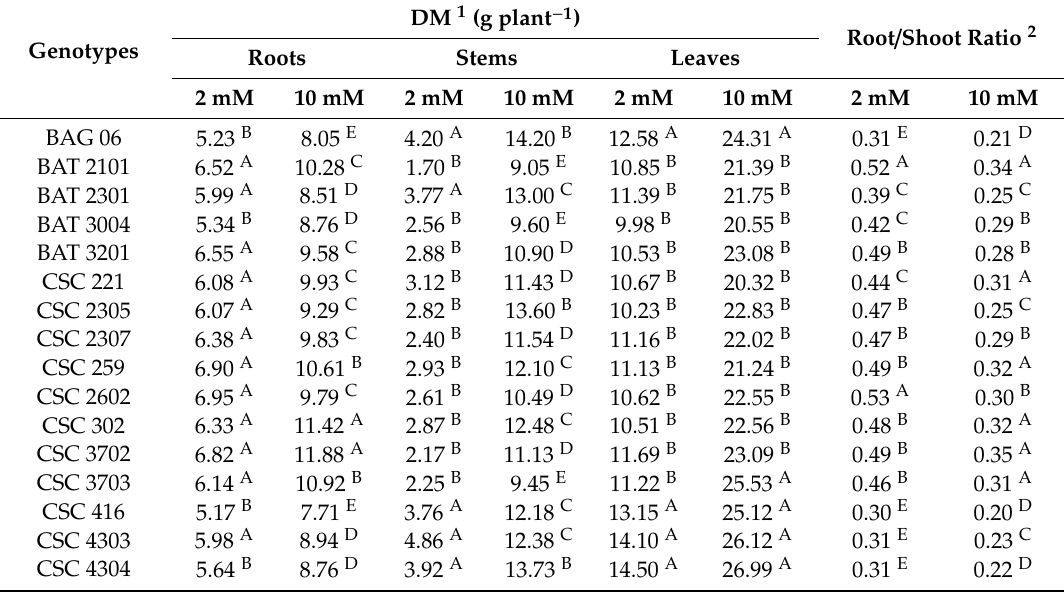
Table 1. Means of dry mass (DM; g plant − 1 ) of the roots, stems, and leaves and the root / shoot ratio of 28 genotypes of tobacco grown at 2 and 10 mM of nitrogen